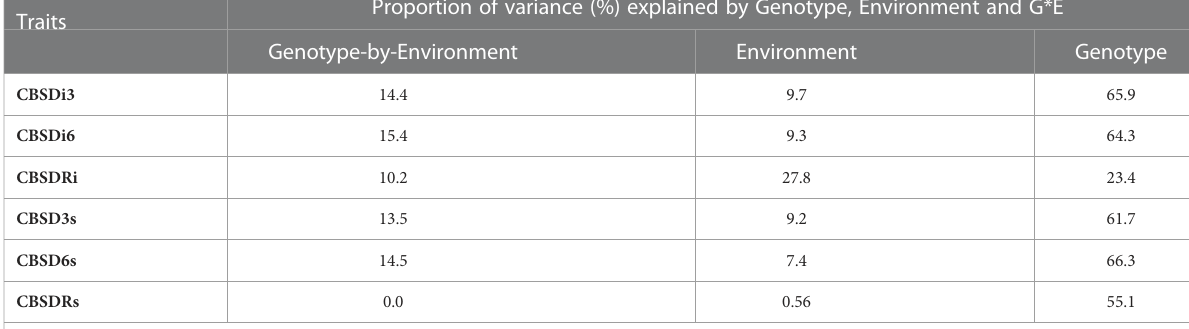
TABLE 3 Apportioning of variance components from the full model. Proportion of variance (%) explained by Genotype, Environment and G*E Traits